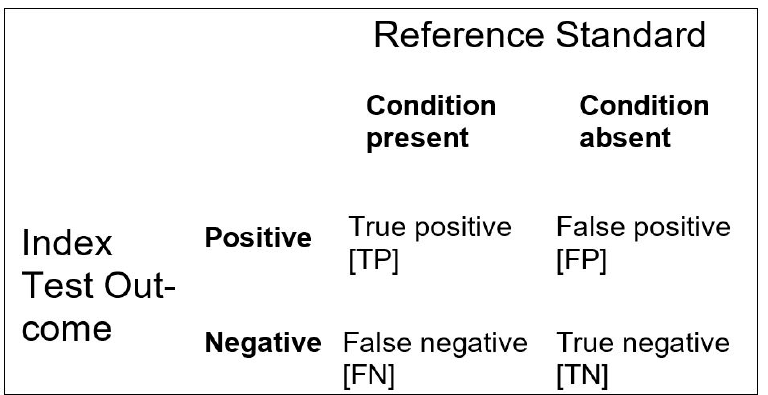
Figure 1. Standard 2 × 2 contingency table for diagnostic or screening test accuracy studies and formulae for paired measures.